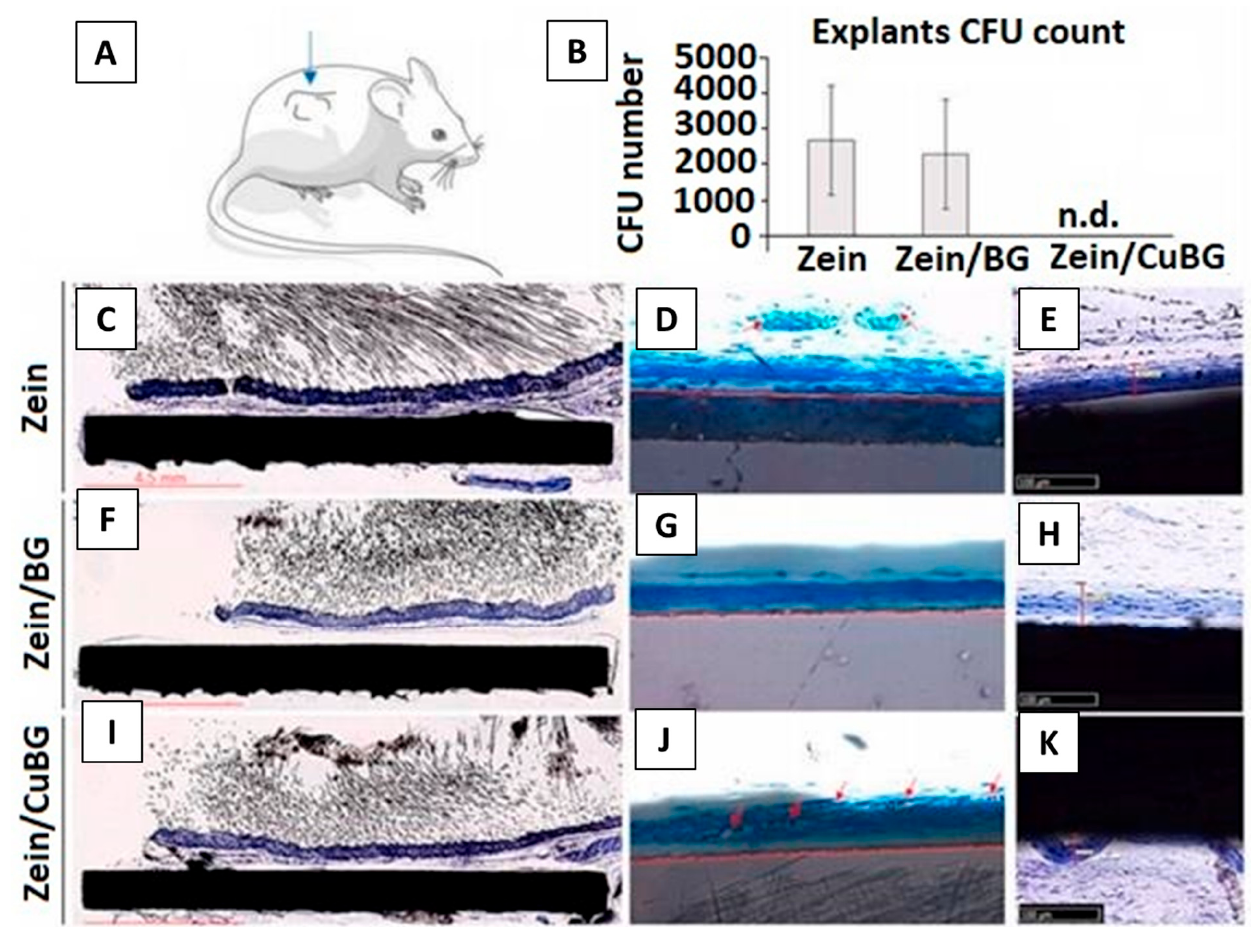
Figure 19. In vivo results. ( A ) Cu addition (zein/CuBG) caused the inhibition of the induced infection ( B ) in comparison with zein (control) and zein/BG. All zein ( C – E ), zein/BG ( F – H ), and zein/CuBG ( I – K ) coatings supported similar tissue thickness formation. Vessels count ( D – J ) confirmed that zein/CuBG coatings recruited the highest number of vessels (indicated by red arrows). Reproduced from [88].